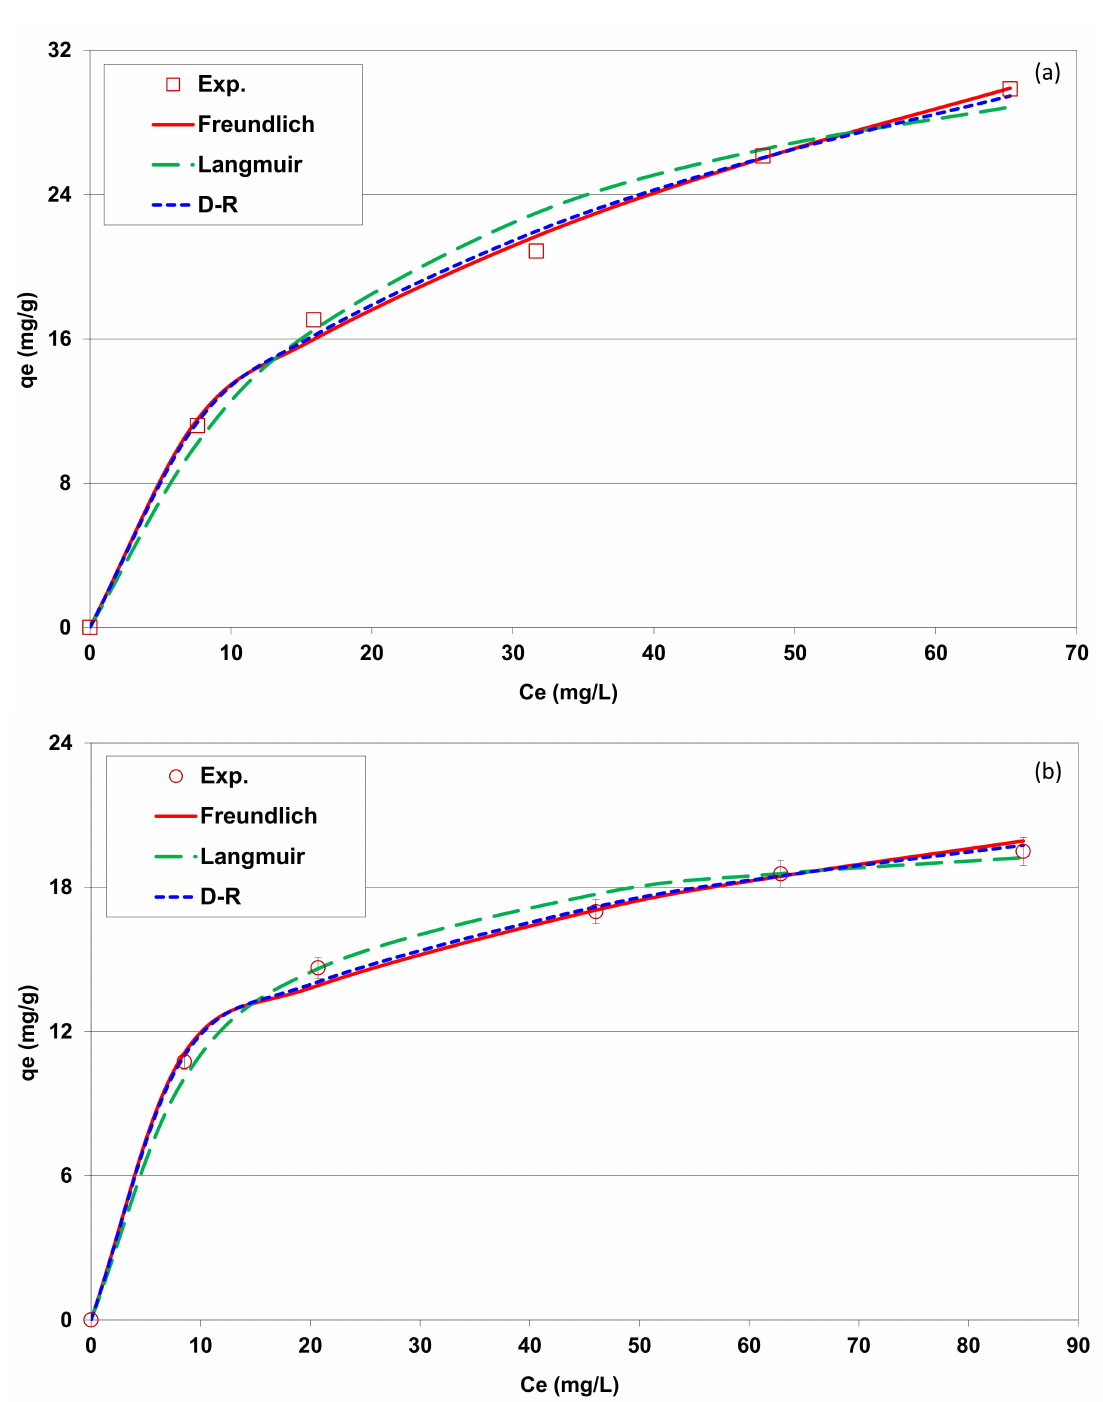
Figure 6. Isotherm experimental and fitted data with Freundlich, Langmuir and Dubinin–Radushkevich (D-R) models for Cd ( a ) and Cu ( b ) removal by lignite (D = 2 g L − 1 ; t = 60 min; pH = 5; T = 20 ± 2 ◦ C; Exp.: Experimental